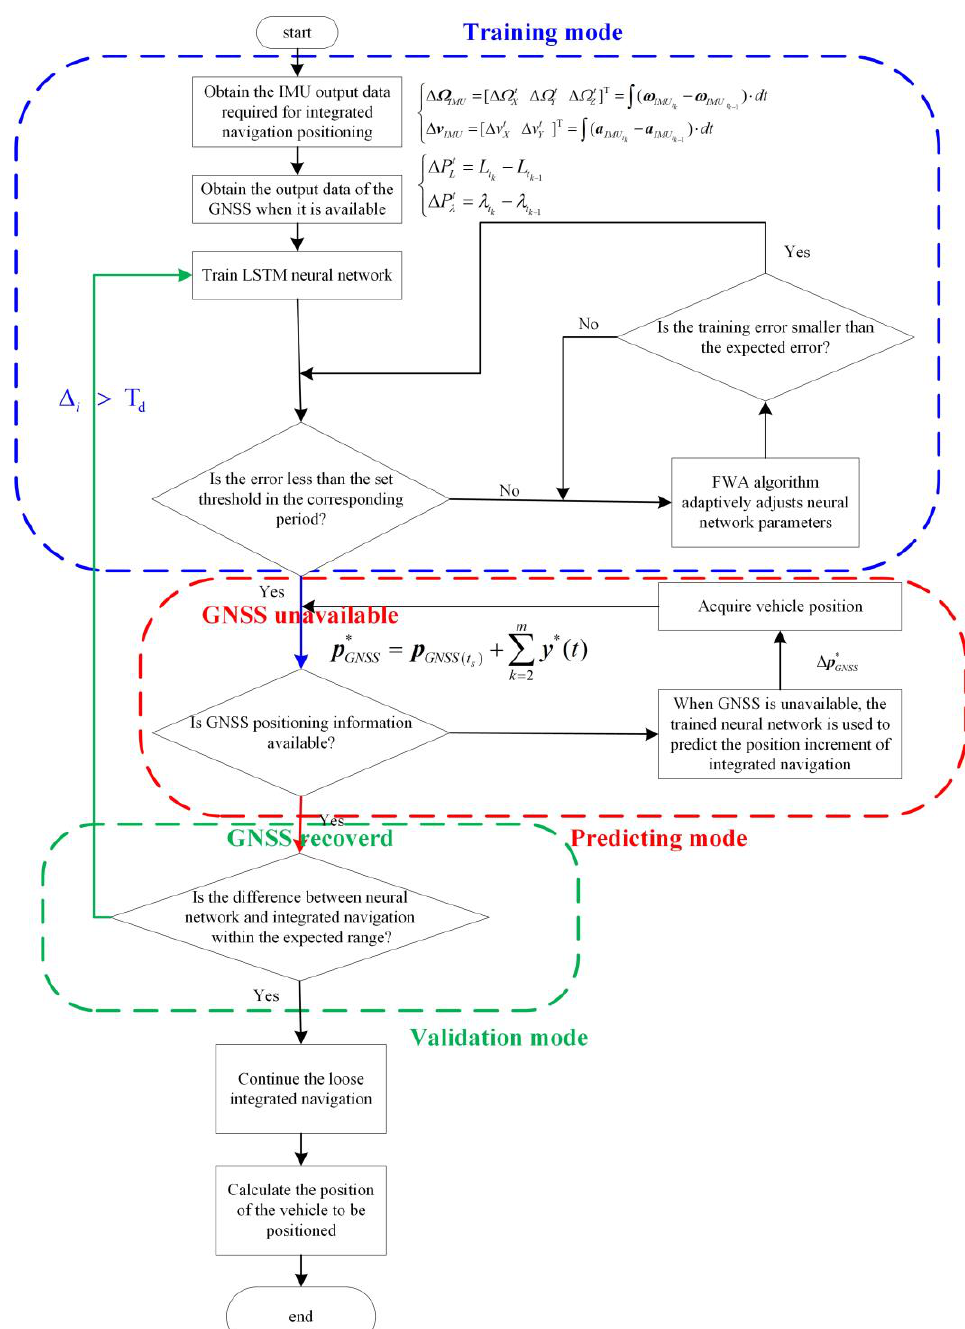
Figure 9. Flow chart of LSTM assisted navigation method.